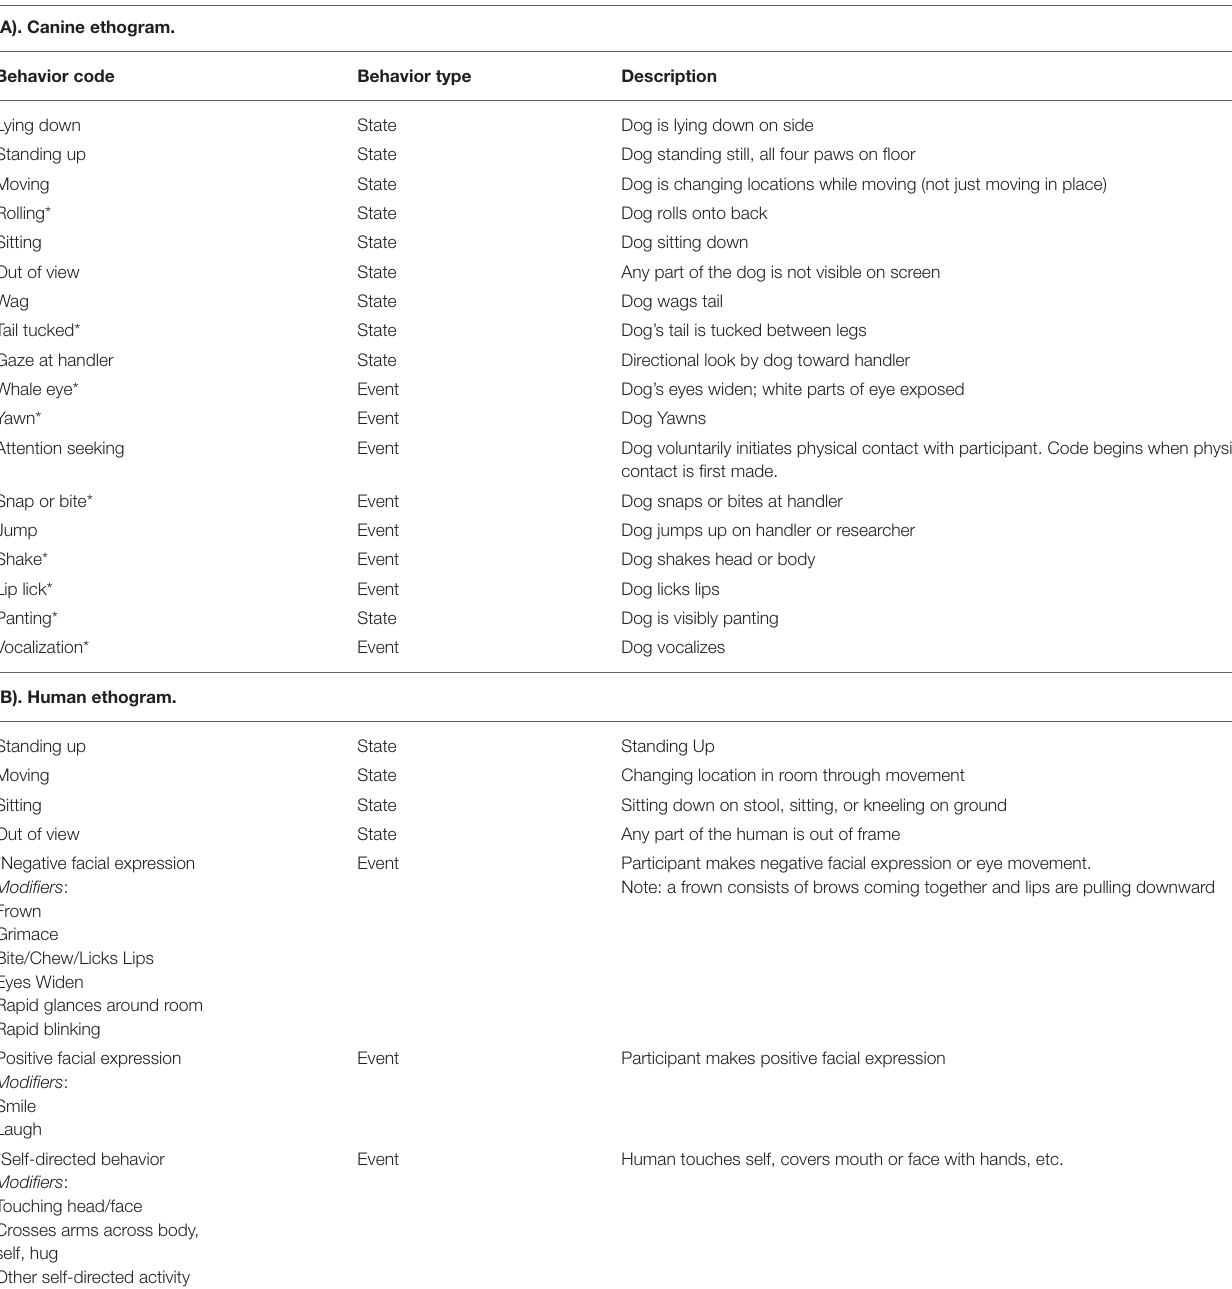
TABLE 2 | Ethograms used for tabulating participant behaviors from the digital video recordings canine (A) and human (B) . (A). Canine